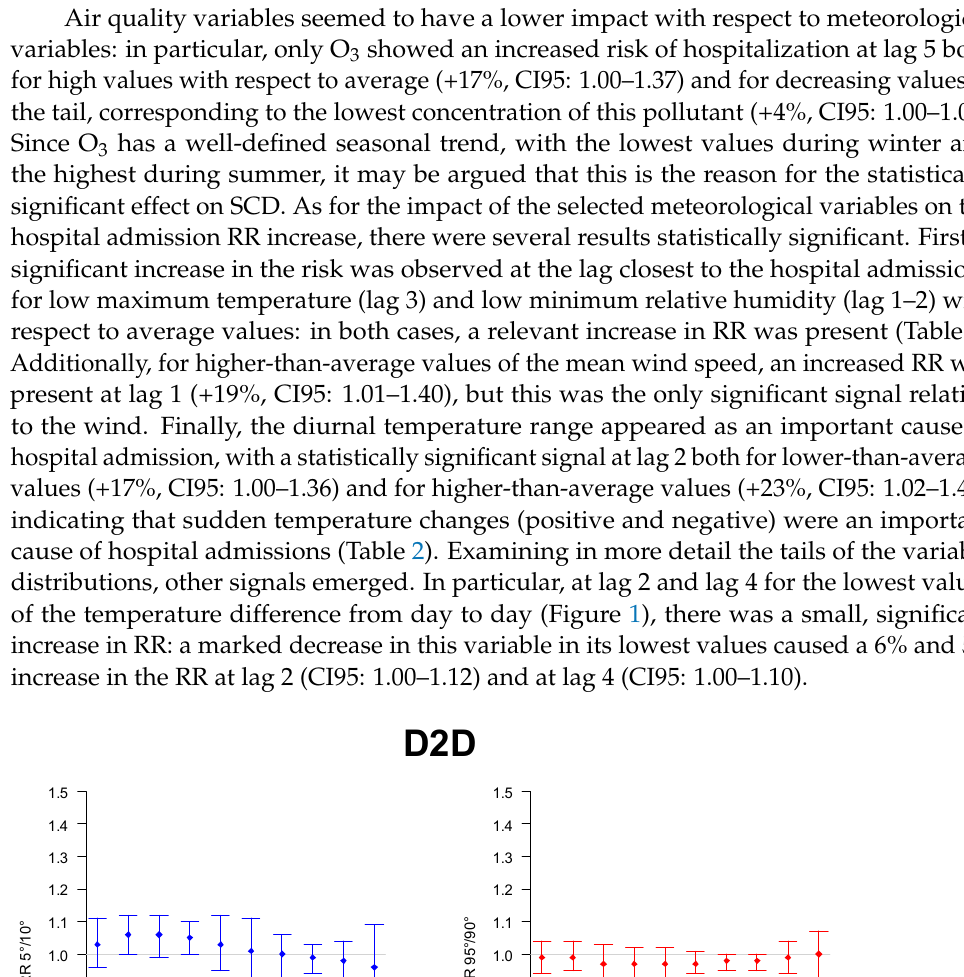
Table 3. Relative risk of hospital admission in the lowest (“RR5vs10”) and highest tail of the variable distribution (“RR95vs90”). PMED: mean atmospheric pressure; PMIN: minimum atmospheric pressure, TMAX maximum temperature; TMED: mean temperature; D2D: temperature difference with respect to the previous day; O 3 : ozone. ICinf: inferior extreme of the 95% level confidence interval; ICsup: superior extreme of the 95% level confidence interval; intervals above 1 are highlighted.